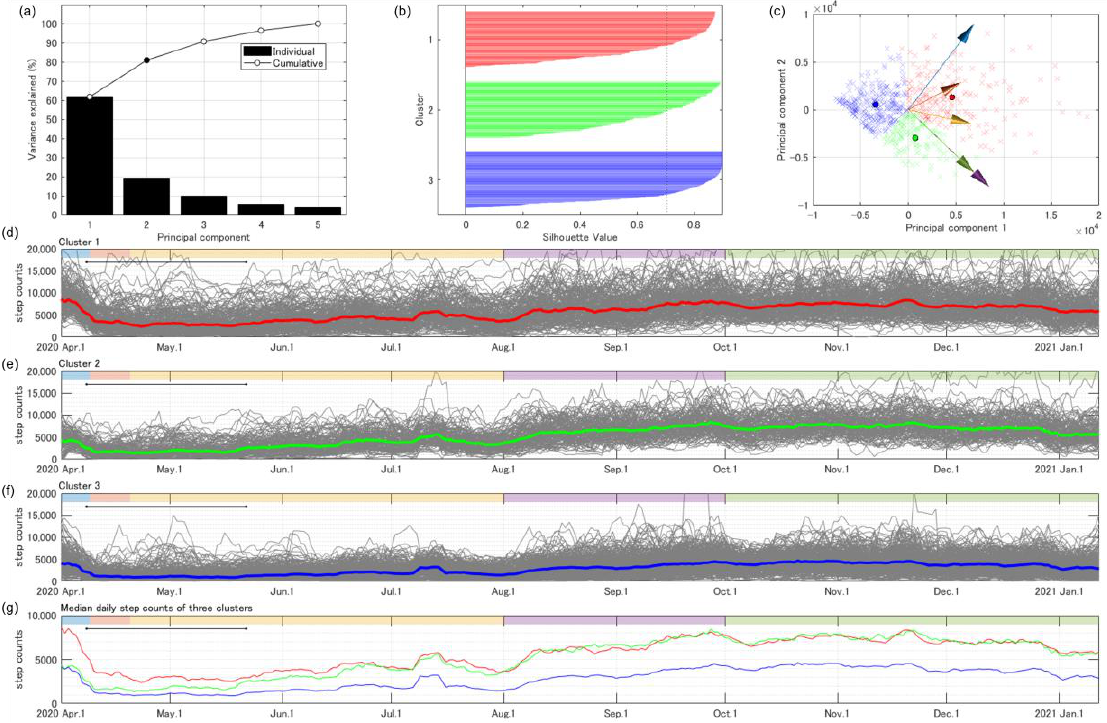
Figure 5. ( a ) Variance explained by the principal components extracted through the principal com- ponent analysis. ( b ) The accuracy of clustering was evaluated using the silhouette plot. The dotted line shows the mean silhouette value (0.704). ( c ) Biplot of scores of 603 participants (×) divided into three clusters (red, green, and blue) with the vectors of five original variables (arrows) on the plane determined by two principal components. The colors of the arrows correspond to the colors of each period in Figure 4. Circles show the mean value for each of the three clusters. ( d – f ) Time-series changes in the daily step counts with 7-day moving average in three clusters are represented with gray lines, and median values across participants are represented with red (cluster 1), green (cluster 2), and blue (cluster 3). ( g ) There is a unique pattern of time-series changes between 3 clusters.